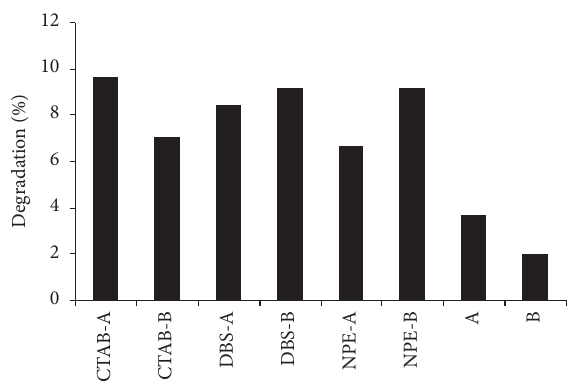
Figure 9: Photocatalytic activity of the current catalysts for naph- thalene